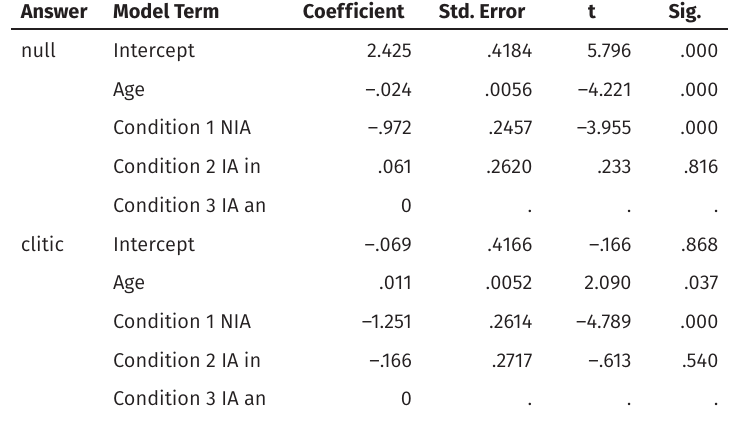
Table 2: Fixed coefficients for NP as selected target in the different